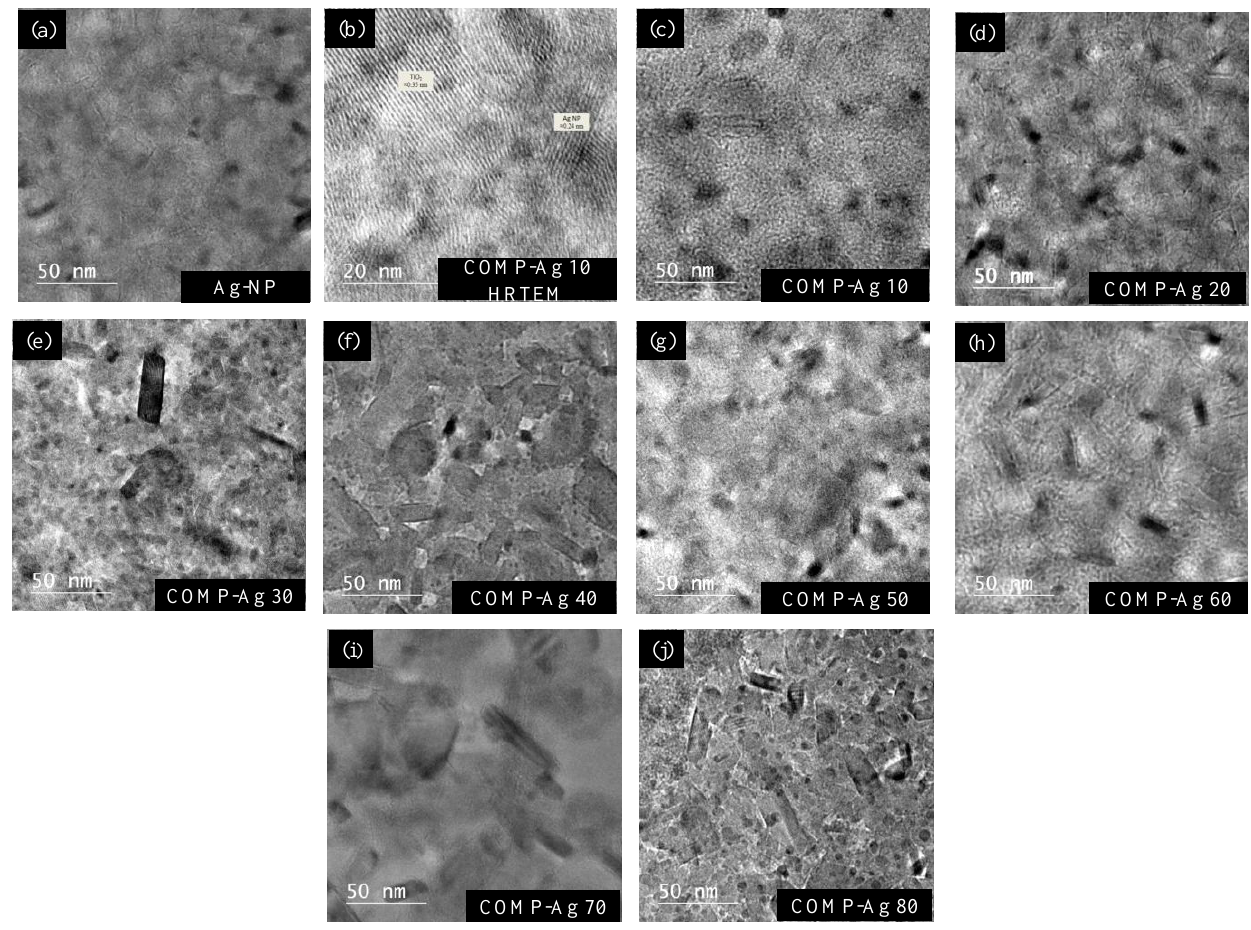
Figure 3. ( a ) TEM image of Ag NP; ( b ) HRTEM image of COMP-Ag10, and ( c )–( j ) TEM images of Ag-NP/TiO composite thin films at various amounts of Ag molar 2 concentrations: ( c ) 10; ( d ) 20; ( e ) 30; ( f ) 40; ( g ) 50; ( h ) 60; ( i ) 70 and ( j ) 80, respectively.